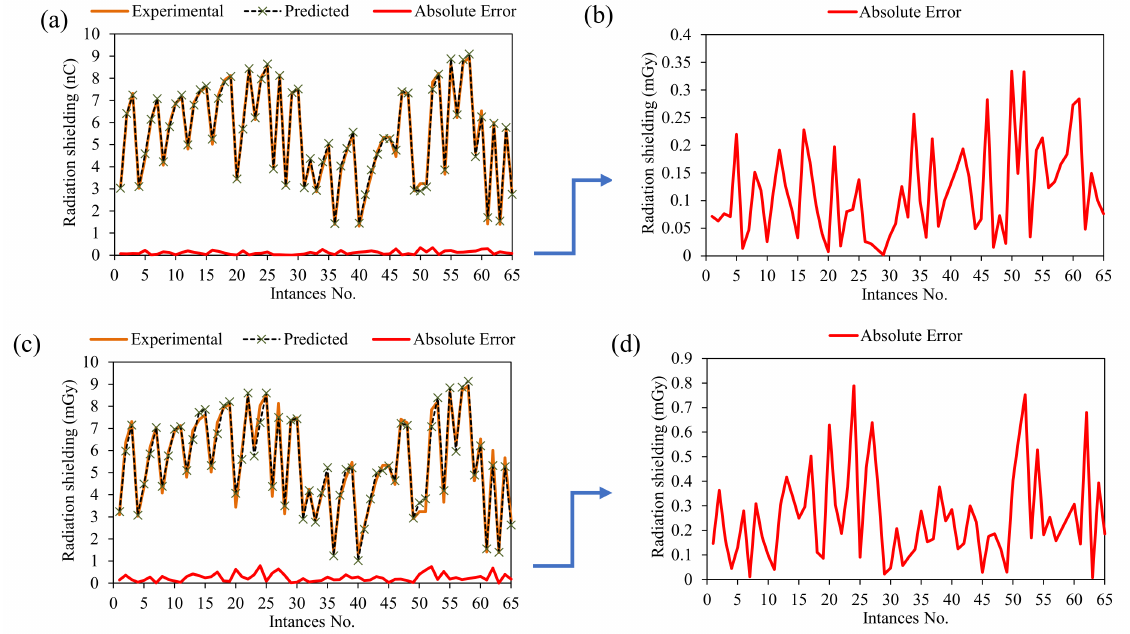
Figure 8. Error analysis of the developed models: ( a ) tracing of experimental by predictions for ANN model, ( b ) absolute error from ANN model, ( c ) tracing of experimental by predictions for GEP model, and ( d ) absolute error from GEP